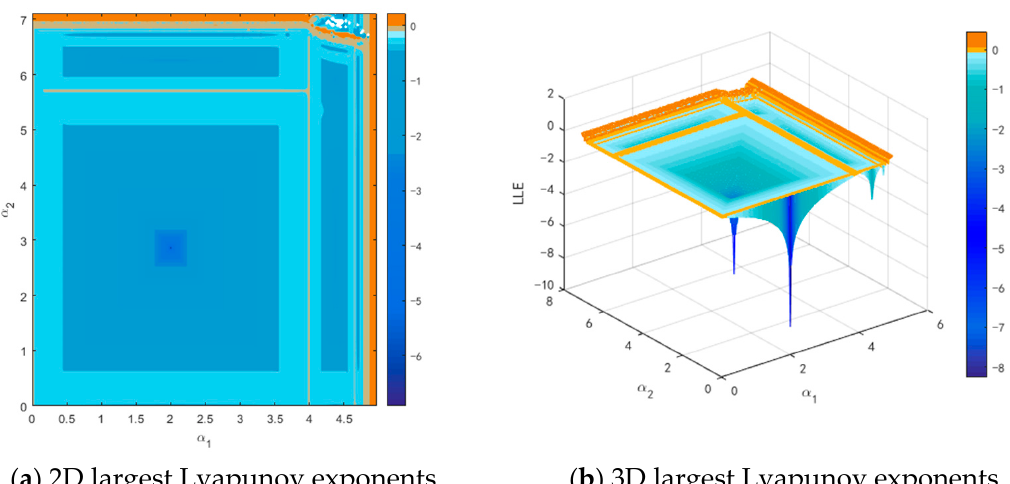
α α and . 1 2 α α and 2 on expected utili-